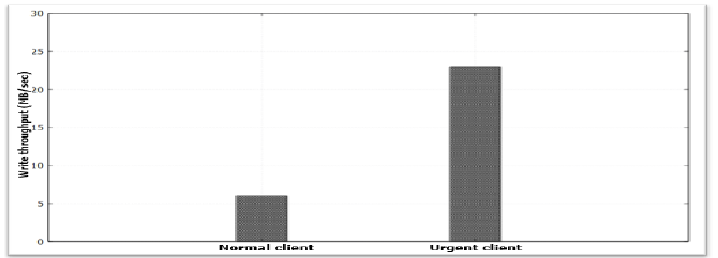
Figure 11. Effect of the normal/urgent separation: the heterogeneity-aware approach can obtain the benefit of SSDs at client layer (compare with Figure 4).